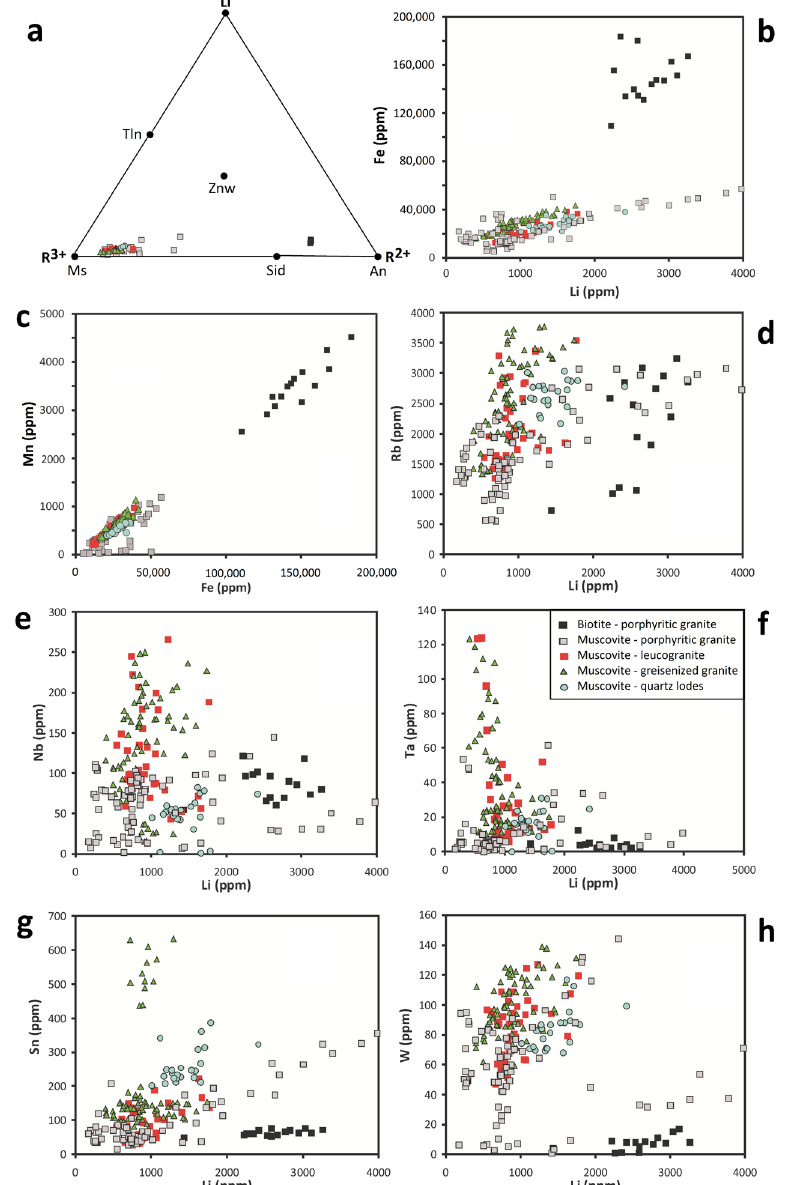
Figure 8. The classification and contents of minor and trace elements in micas: ( a ) classification diagram of Li-micas according to Foster [38]; ( b ) Li vs. Fe; ( c ) Fe vs. Mn; ( d ) Li vs. Rb; ( e ) Li vs. Nb; ( f ) Li vs. Ta; ( g ) Li vs. Sn; ( h ) Li vs. W. Means of samples are shown in Figure a (combination of EMP and LA data) while individual LA spots are shown in other figures.